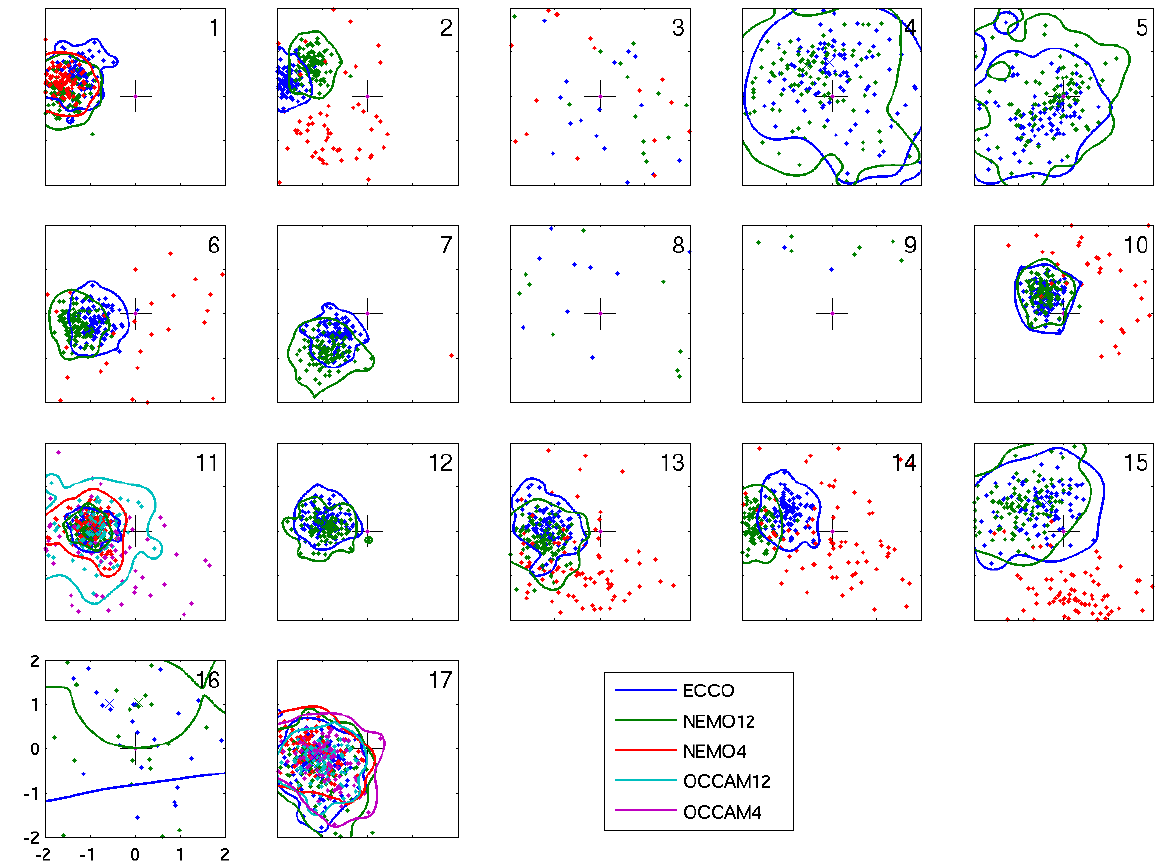
Figure 6. Comparison of p ANN m derived from different models, for each site. Models are indicated as ECCO (blue), NEMO12 (green), NEMO4 (red), OCCAM12 (cyan), OCCAM4 (magenta). 95% of results lie within the contours. No contours are plotted if there is less than 13 months overlap between model and record data at a site. Subplot axes are identical to Fig.